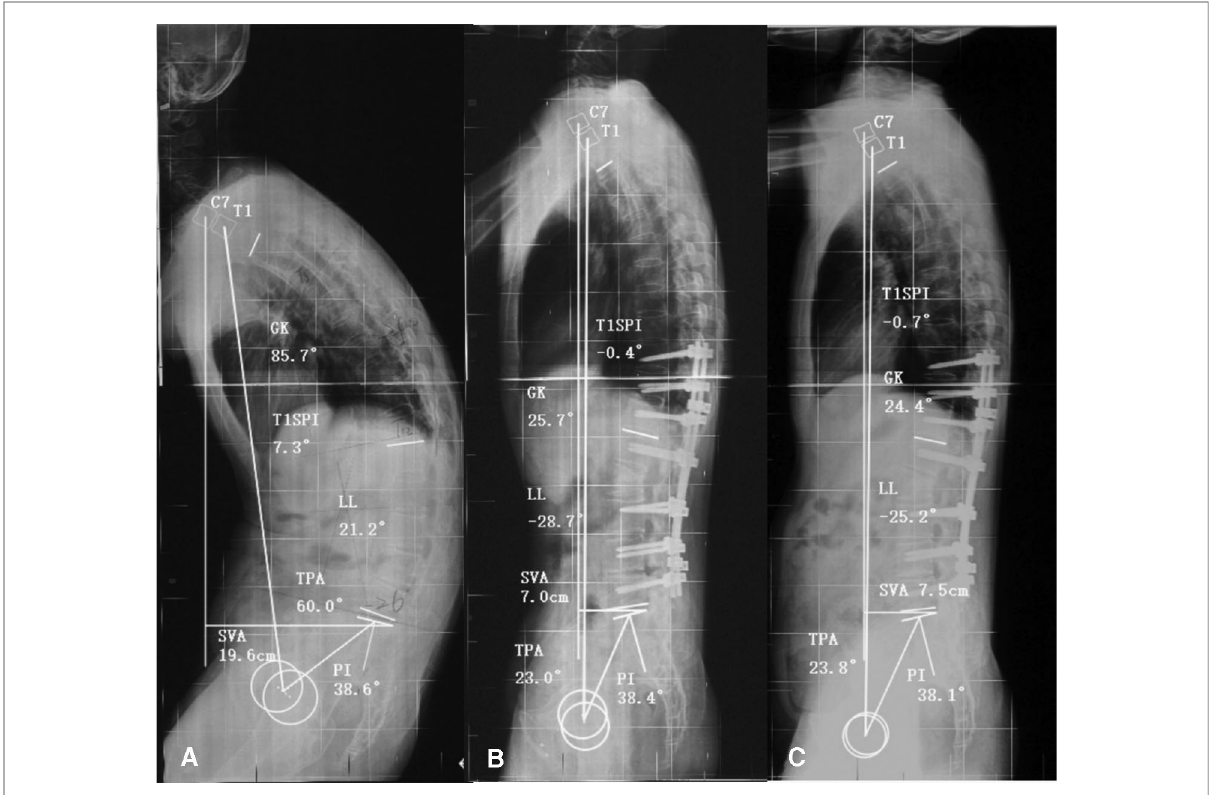
FIGURE 4 A 37-year-old man with ankylosing spondylitis kyphosis for 11 years. ( A ) The preoperative sagittal parameters were pelvic incidence (PI)=38.6°, T1 spinopelvic inclination (T1SPI)=7.3°, T1 pelvic angle (TPA)=60.0°, and sagittal vertical axis (SVA)=19.6 cm. ( B ) After L2 corrective osteotomy, the immediate postoperative sagittal parameters were PI=38.4° (<49.2°), T1SPI= − 0.4° (<0.9°), TPA=23.0° (<31.5°), and SVA=7.0 cm (<9.3 cm), all of which met the optimal parameter threshold values. ( C ) At the 25-month follow-up, the correction was well maintained, with PI=38.1°, T1SPI= − 0.7°, TPA=23.8°, and SVA=7.5 cm. The patient presented with a favorable health-related quality of life (total Oswestry Disability Index (ODI)= 0, total Scoliosis Research Society-22